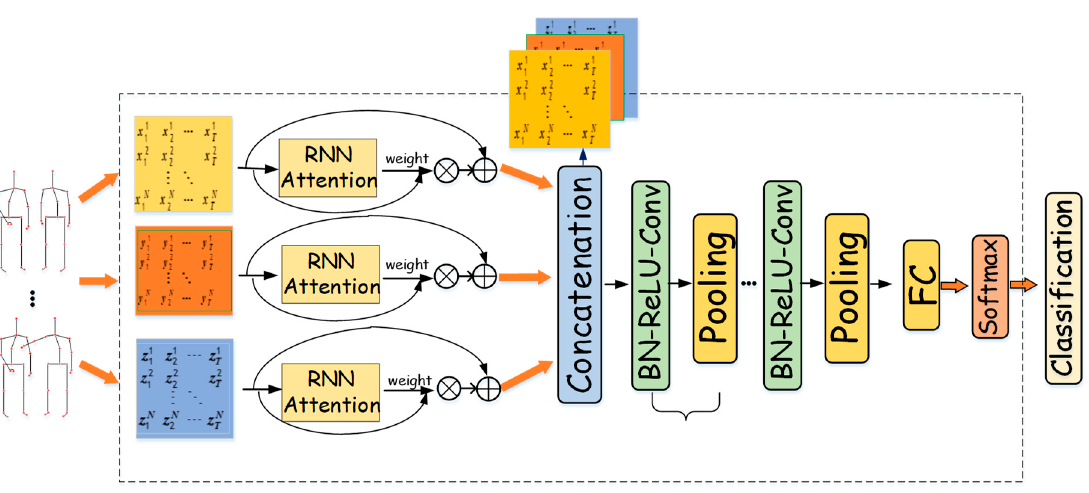
Figure 1. Basic framework of the subnet.